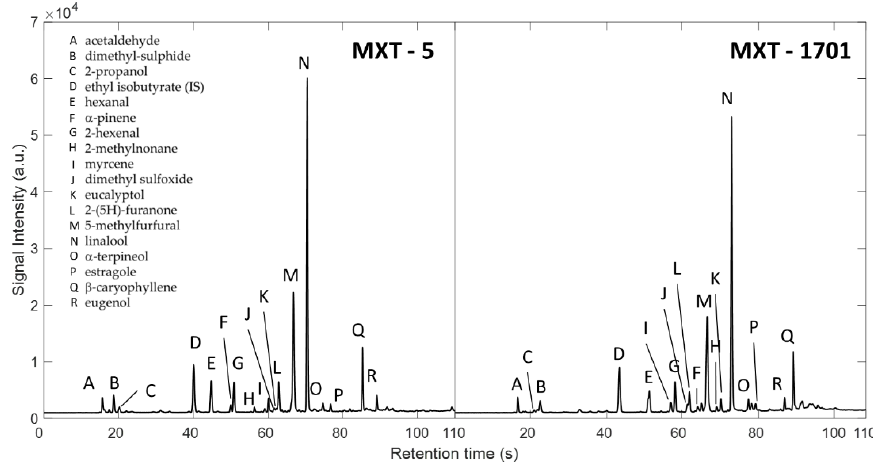
Figure 9. Chromatograms of the Italiano Classico variety obtained by elution on columns MXT-5 and MXT-1701 of Heracles II.